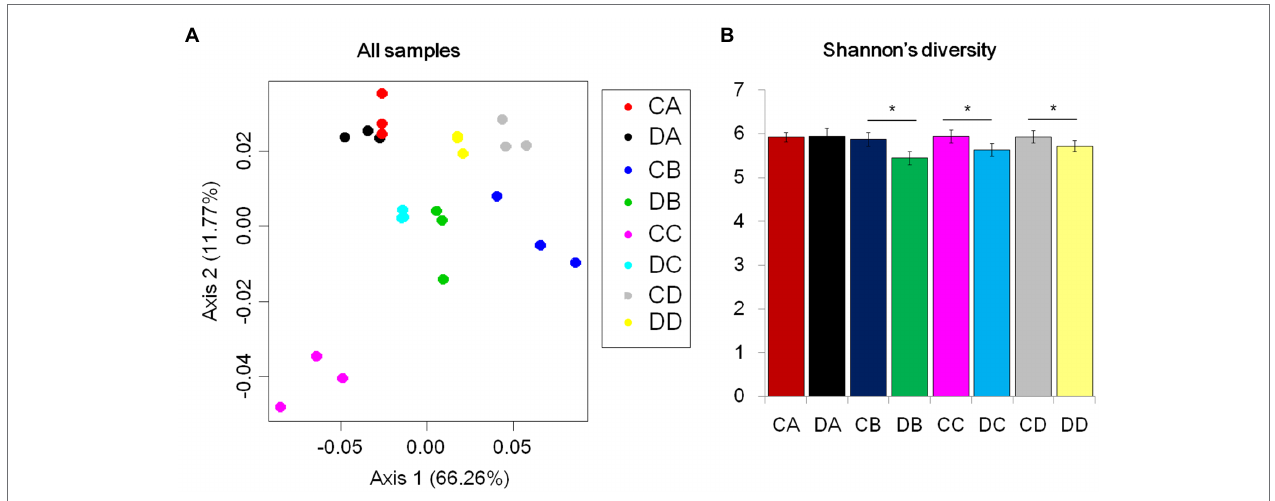
FIGURE 1 | Drought impacts on root and soil microbiome development. (A) Principal coordinate analysis (PCoA) of Bray-Curtis distances for all control and drought samples. The color of each point indicates the control or drought treatment. (B) Mean Shannon’s diversity across the rhizosphere. (* p < 0.05; *Tukey’s